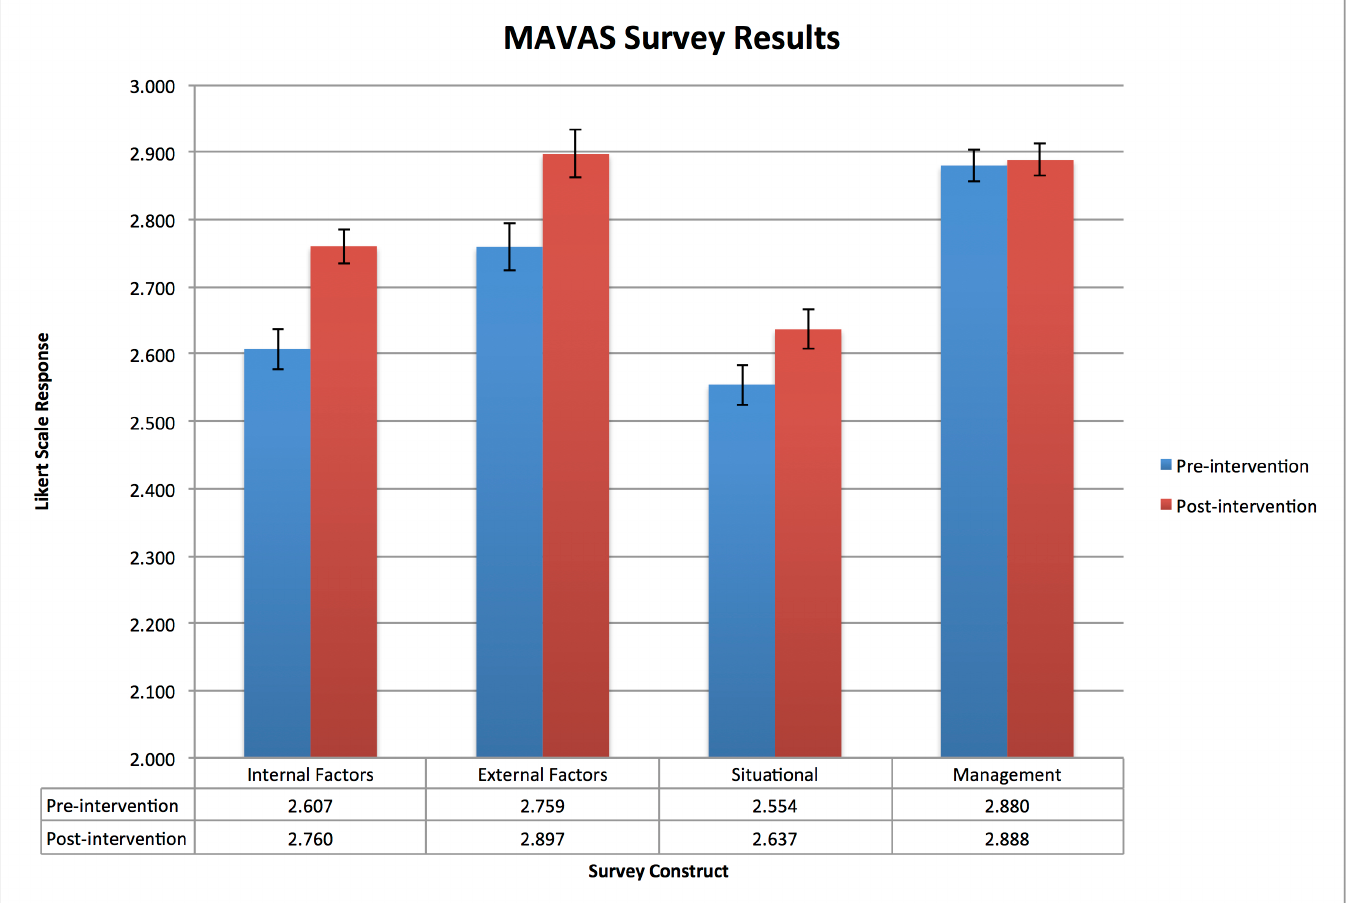
Figure 2. Management of Aggression and Violence Attitude Scale (MAVAS) survey results showing emergency department personnel’s changes in attitude to patient aggression after participation in course on managing agitated